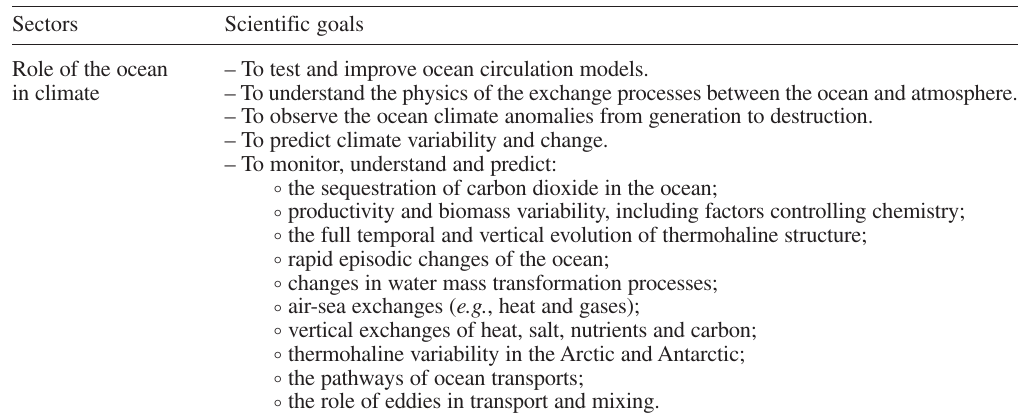
Table I. List of scientific goals where the Seafloor Observatory Science is very useful (NRC, 2000).